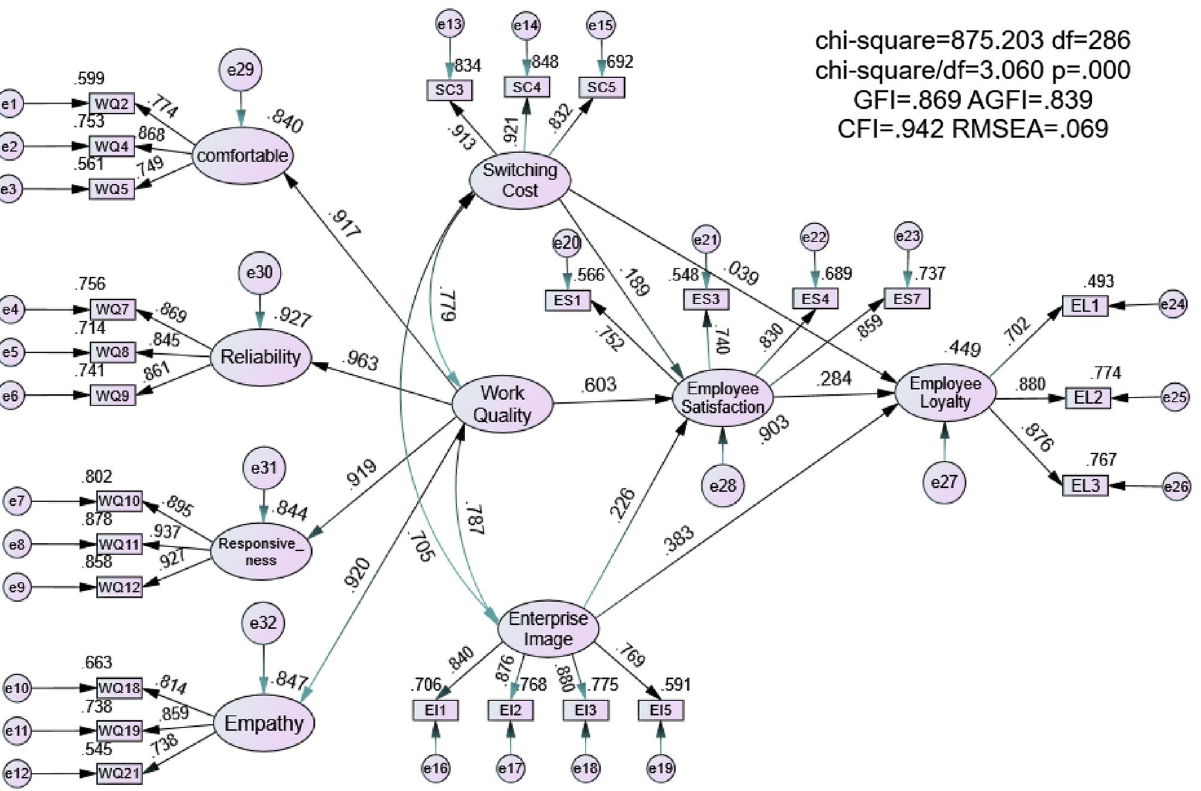
Figure 2. Structural equation model showing standardized path